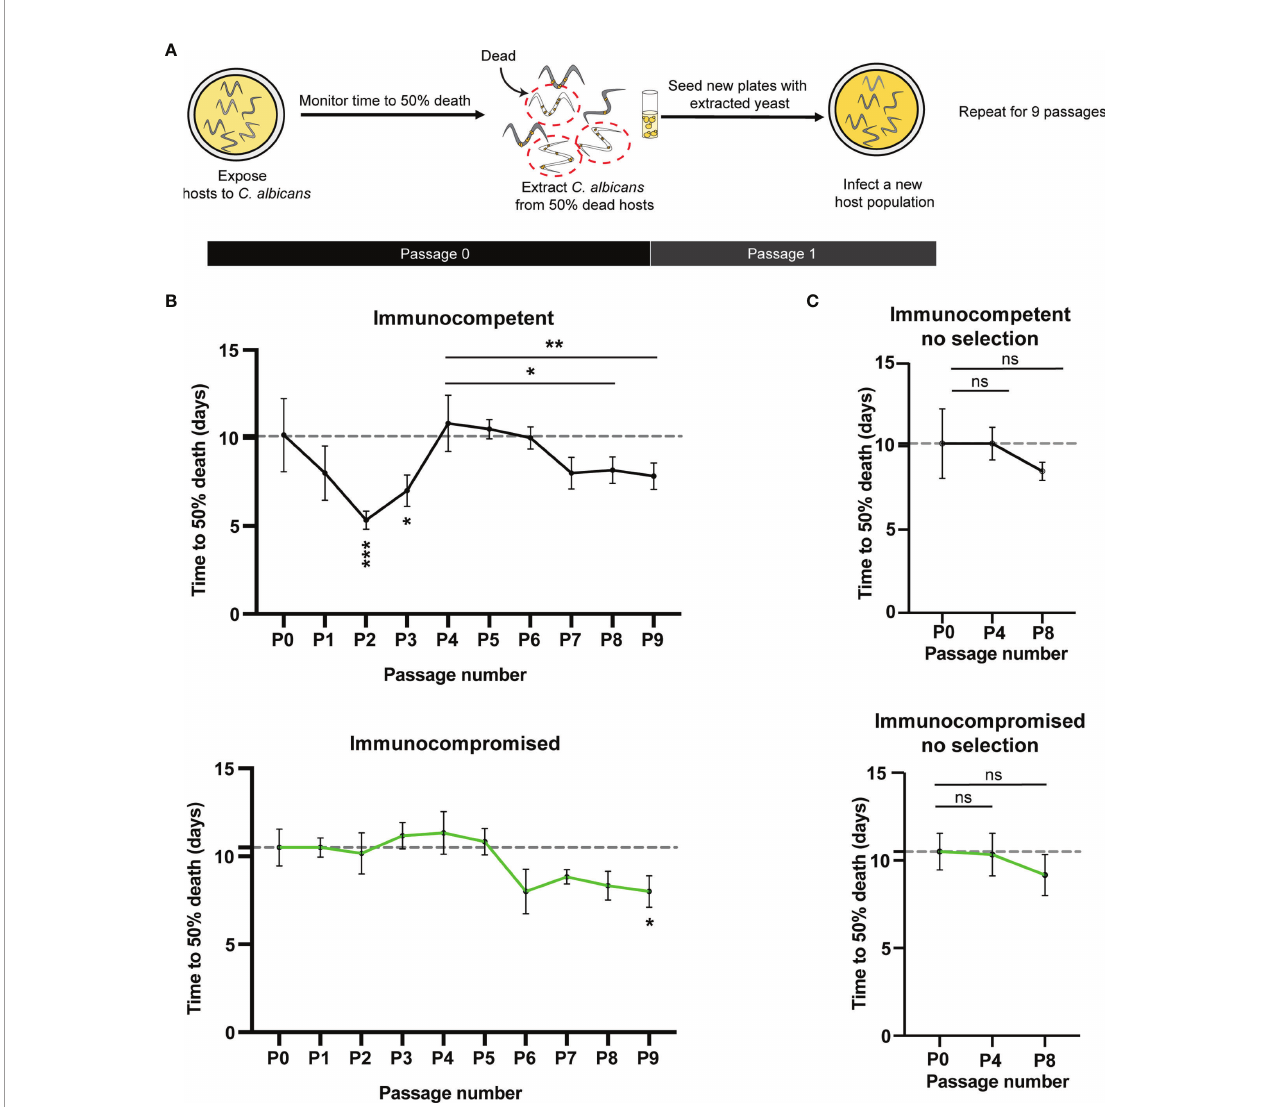
FIGURE 1 | Tetraploid C.albicans evolve rapidly in immunocompetent hosts under selection (A) Experimental evolution schematic (B) top:Time to 50% death for ten passages in healthy, immunocompetent (glp-4) hosts. Plotted are the mean (n=6) and SD for each passage bottom: Time to 50% death for ten passages in immunocompromised ( glp-4; sek-1) hosts. Plotted are the mean (n=6) and SD for each passage. Asterisks represent signi fi cant differences compared to the initial (PO) time point (***0.005, **p < 0.01, *p < 0.05 Kruskal-Wallis with post-hoc Dunn's multiple test). ns = not signi fi cant. Dashed line indicates the initial average time to 50% death. (C) top: Line graph representing the average and standard deviation for time to 50% death for immunocompetent (glp-4) osts not under selection for the initial passage (PO), passage 4 (P4) and passage 8 (P8). bottom: Line graph representing the average and standard deviation for time to 50% death for immunocompromised ( glp-4 sek-1) hosts not under selection for the initial passage (PO), passage 4 (P4) and passage 8 (P8). Small dots represent individual data points. (ns, not signi fi cant, p > 0.05 Kruskal-Wallis with post-hoc Dunn ’ s multiple